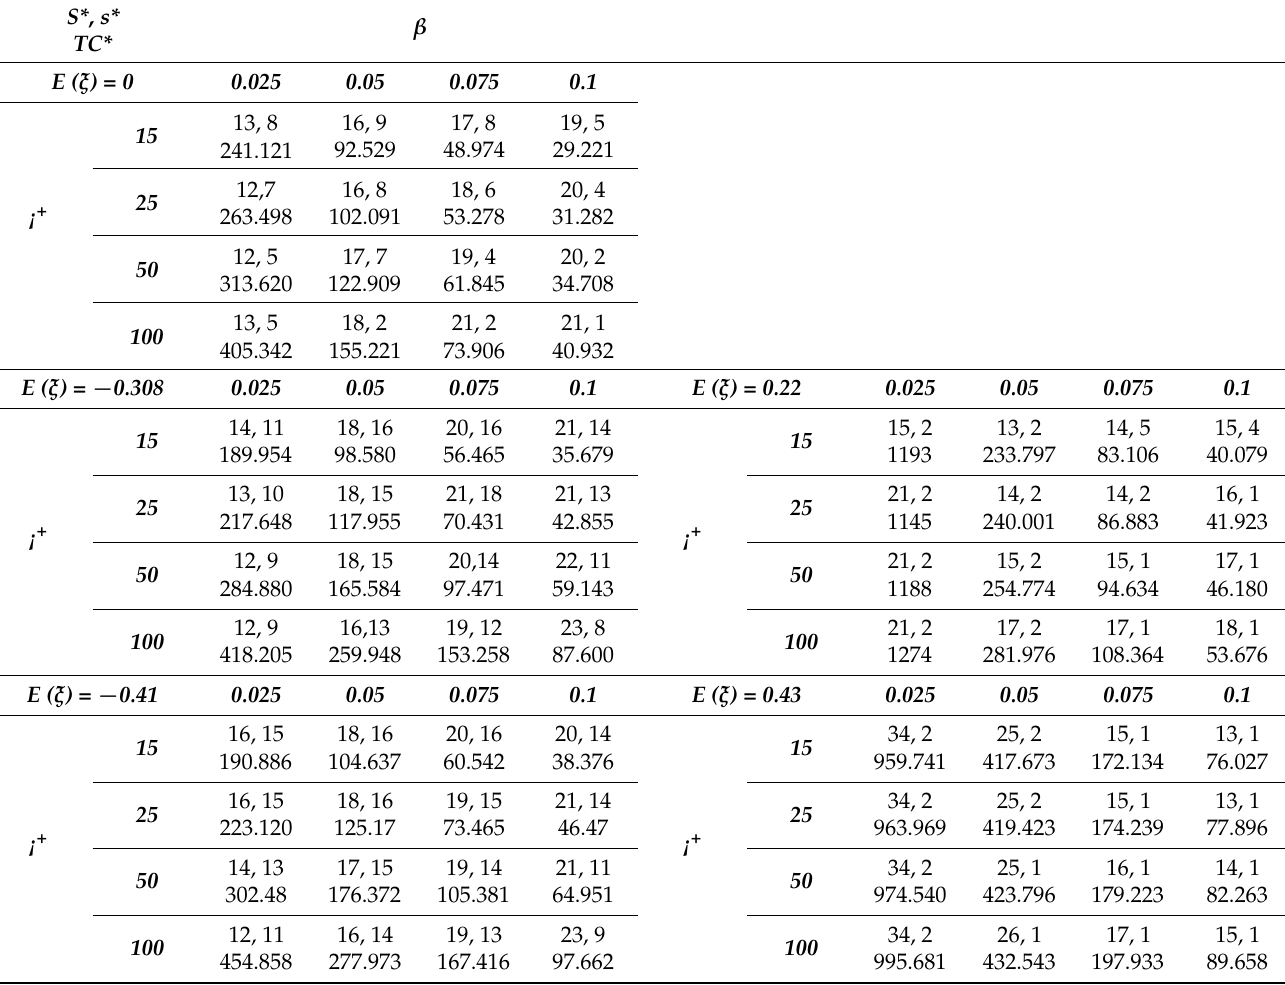
Table 4. ( S ∗ , s ∗ ) , TC ( M = 35, S ∗ , s ∗ ) as a function of β , E ( ξ ) , and Υ +